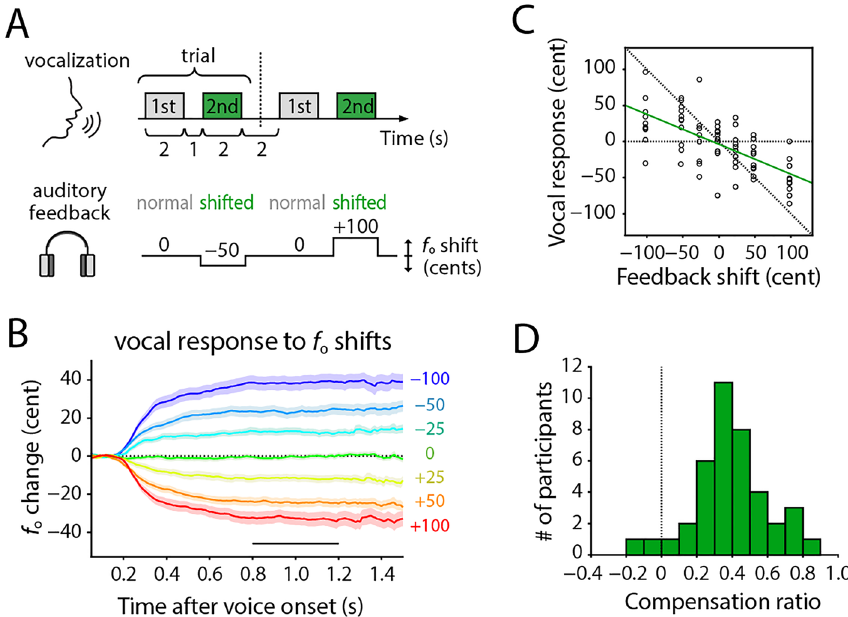
Figure 1. Measuring compensatory responses in vocal fundamental frequency ( f o ) against artificially induced f o shifts in auditory feedback. ( A ) Schematic drawing of the experimental design. Participants vocalized twice in one trial with normal auditory feedback for the first vocalization, and with modified auditory feedback for the second. ( B ) Average of vocal f o change across all participants in response to the seven conditions with the f o shifts in the auditory feedback (0, ± 25, ± 50, or ± 100 cents). All trajectories were aligned at vocal onsets, and detrended before averaging (see “Methods” for detail). Pale-colored area indicates the standard error ( n = 40). ( C ) Example of compensation amounts as a function of f o shifts obtained from one sample participant (ID: M04). Each dot indicates the compensation amount in each trial, which was calculated as an average of the plateau period (0.8–1.2 s after voice onset) indicated as a black bar in panel ( B ). The compensation ratio was estimated as a sign-inverted value of the slope of fitted line, shown as a green line. Diagonal dotted line indicates sign-inverted unity slope. ( D ) Histogram of compensation ratios obtained from all participants. Note that here we mainly analyzed data of /a/-vocalized trials (see Fig. 6 for vowel